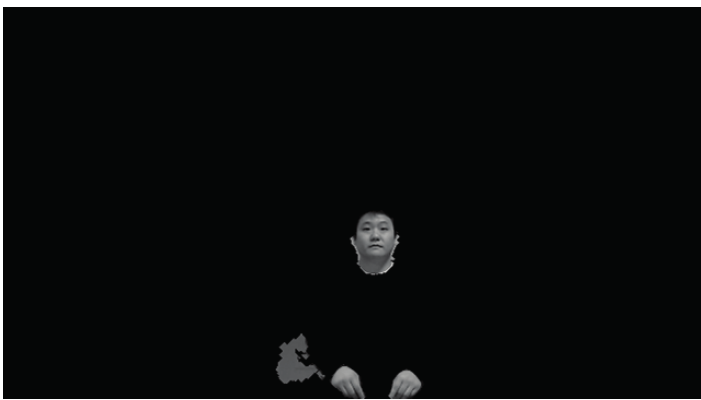
Figure 5. Example of the result from preprocessing by the